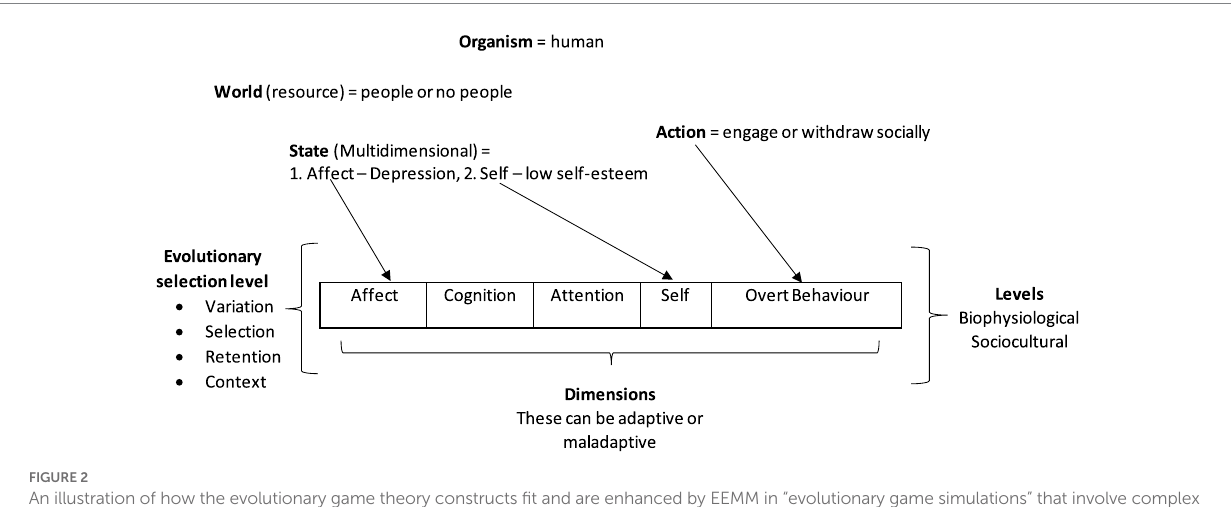
FIGURE 2 An illustration of how the evolutionary game theory constructs fit and are enhanced by EEMM in “evolutionary game simulations” that involve complex mental health